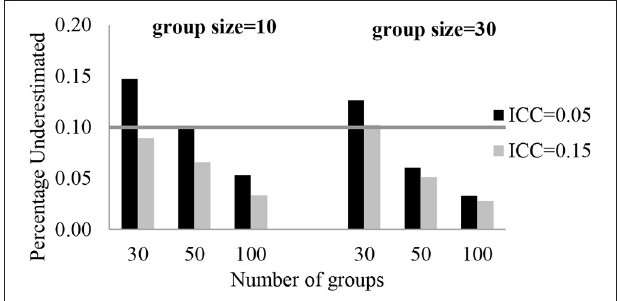
FIGURE 1 | Relative bias for level-3 variance component ( u 00 j